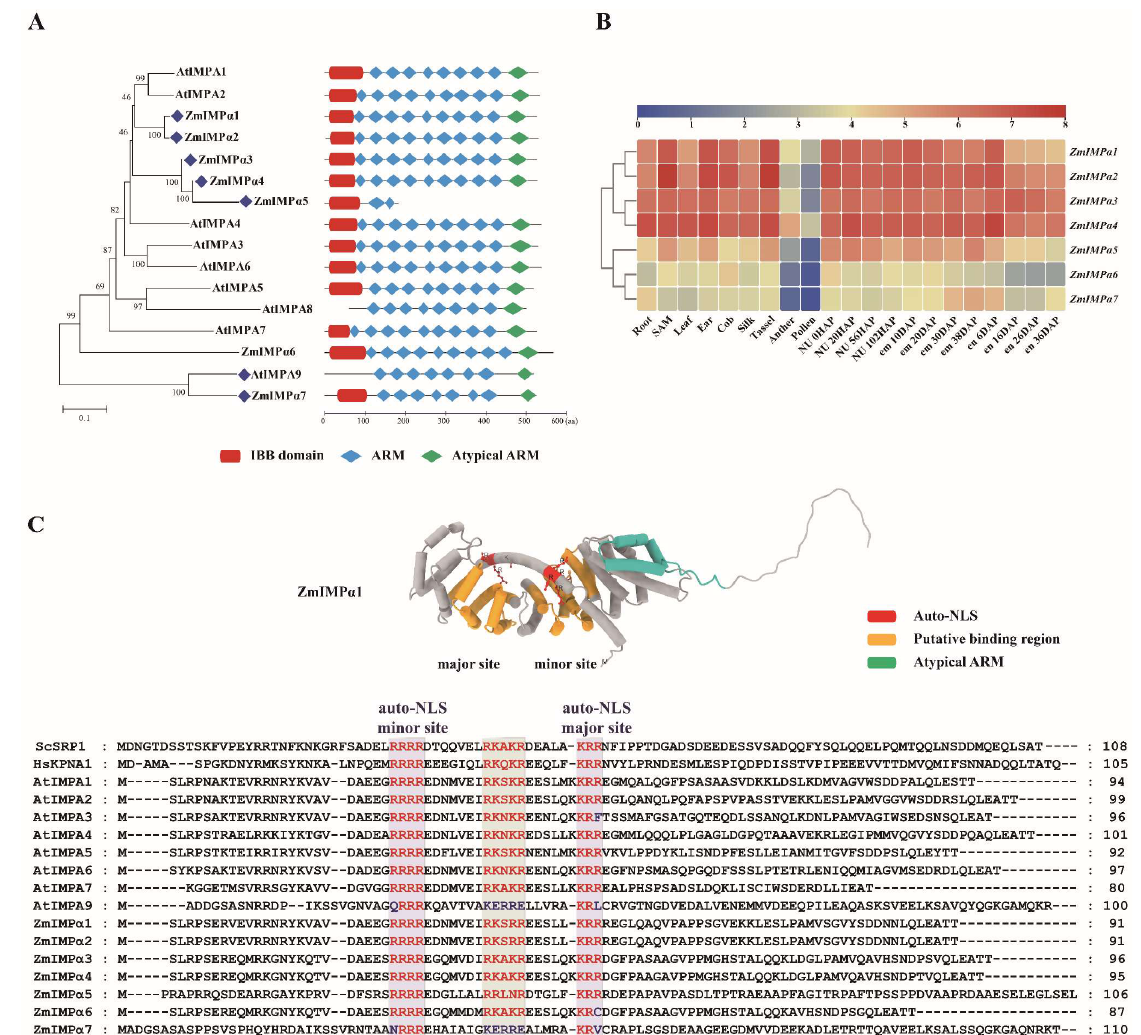
Figure 2. IMPORTIN α family in maize and Arabidopsis . ( A ) Schematic view of the domains conserved between AtIMPA and ZmIMP α proteins according to Pfam Database (https://pfam.xfam.org/ (accessed on 4 October 2022)) and CCD Tools (https://www.ncbi.nlm.nih.gov/Structure/cdd/wrpsb.cgi (accessed on 4 October 2022)); ( B ) Heat map of the expression pattern of ZmIMP α genes, with the expression value calculated by log2 (FPKM). SAM: shoot apical meristem, NU: nucellus, em: embryo, en: endosperm, HAP: Hours after Pollination, DAP: Day after Pollination; ( C ) Signatures of the Importin β binding (IBB) domain of the ZmIMP α 1 protein predicted by AlphaFold Protein Structure Database (https://alphafold.com/ (accessed on 4 October 2022)); multiple amino acid sequences of the IBB domain aligned using CLUSTALW, three conserved motifs highlighted in red and rectangle